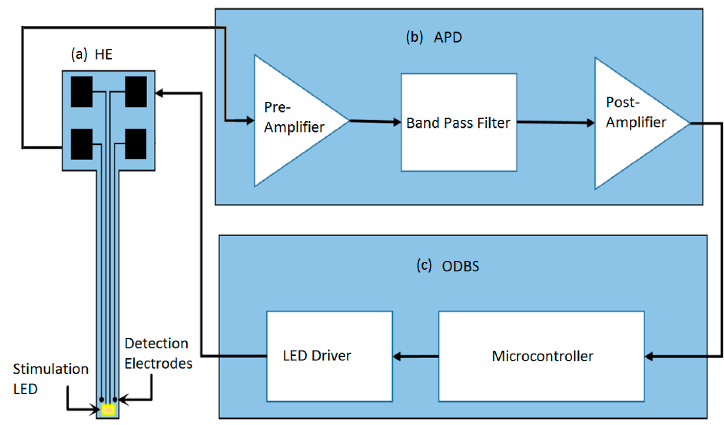
Figure 1. Proposed closed-loop optogenetic stimulation device. ( a ) Hybrid electrode. ( b ) Action potential detector. ( c ) Optogenetic deep brain stimulator.